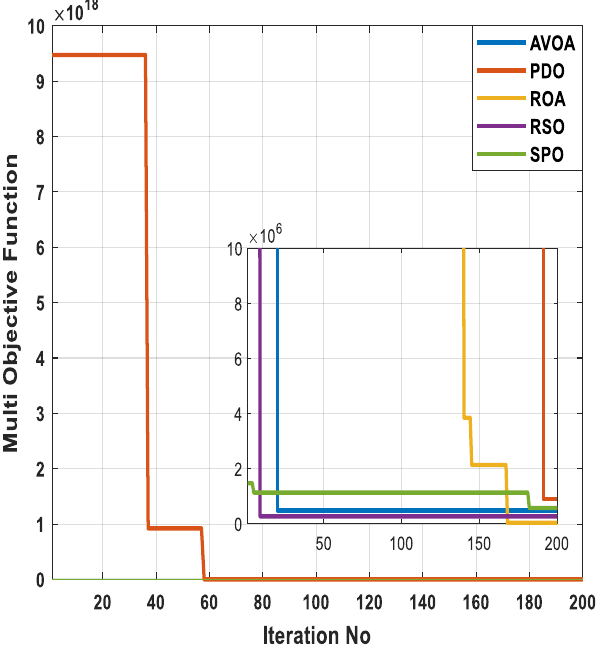
Figure 22. The AVOA convergence characteristics with the other compared methods for case 10.